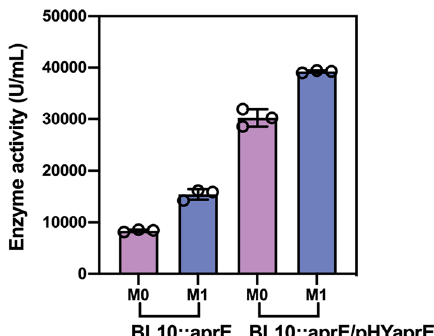
Fig. 5 Alkaline protease synthesis in different media (M0: initial medium; M1: optimized medium) and strains (BL10::aprE and